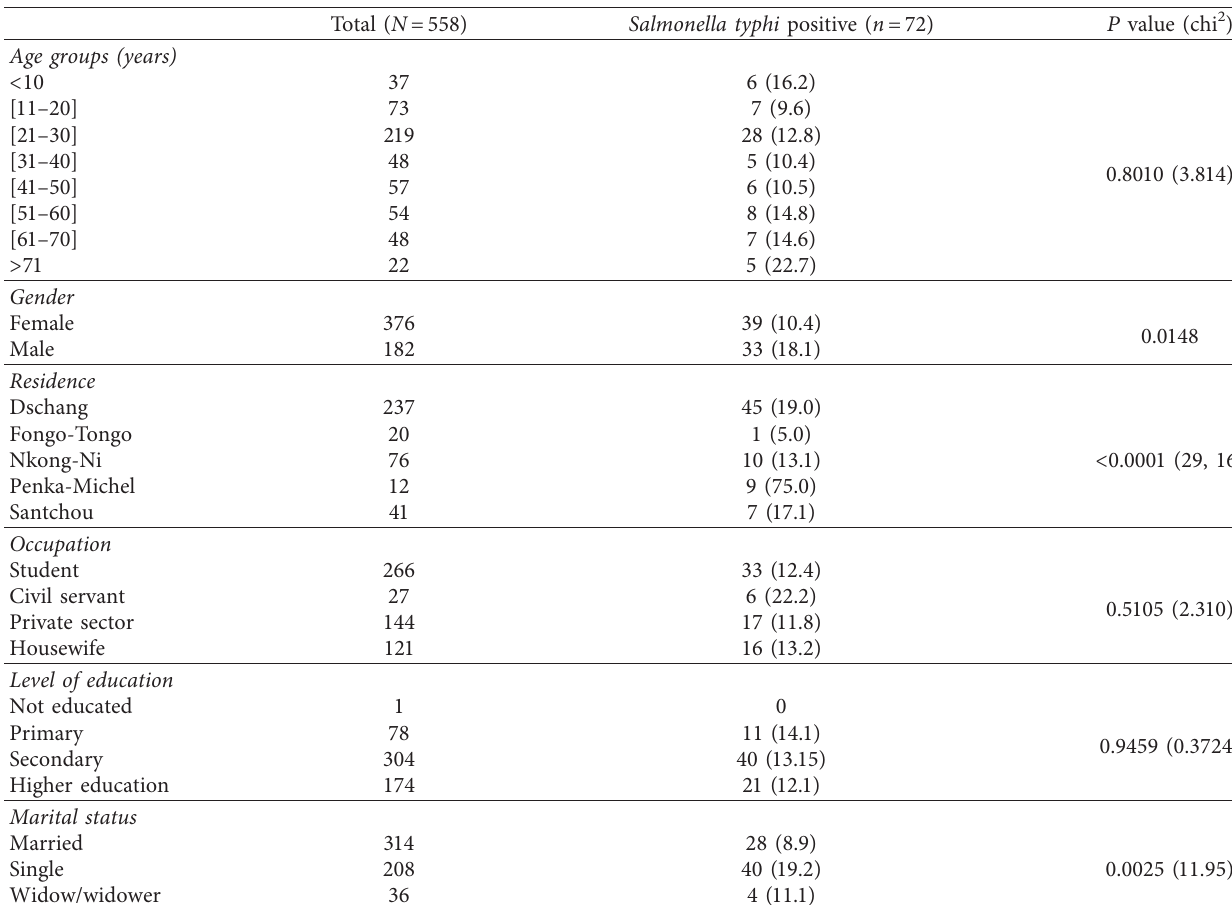
Table 2: Prevalence of typhoid fever by sociodemographic characteristics in the study population.